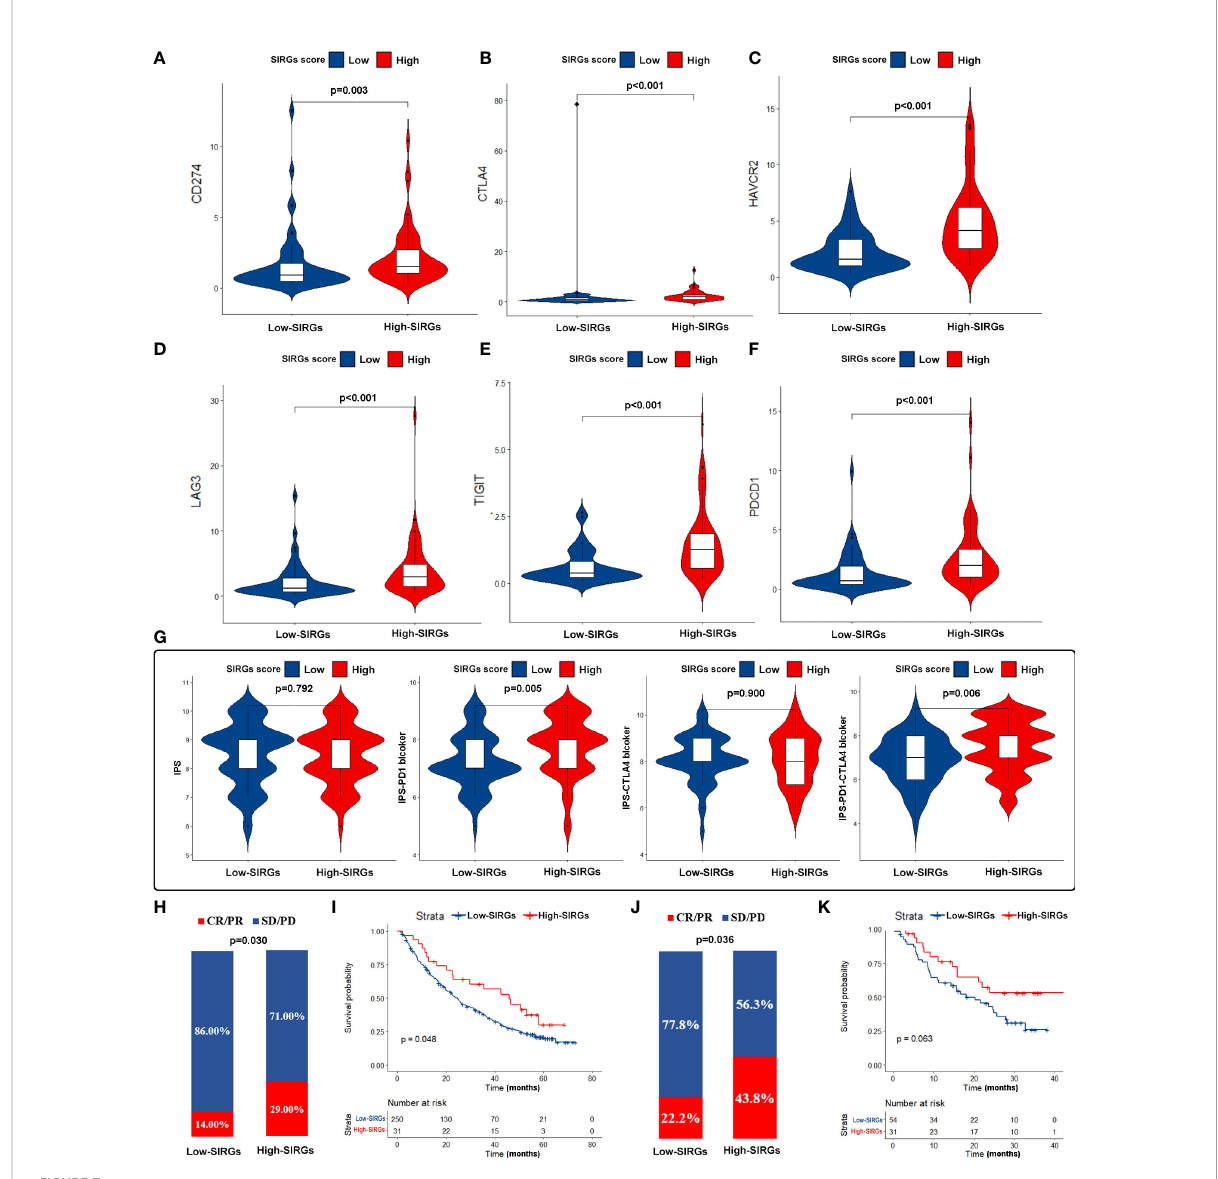
FIGURE 7 The estimation and validation of two SIRGs score groups in immunotherapy response. (A-F) The different expression of six immune checkpoint molecules (CD274, CTLA4, HAVCR2, LAG3, TIGIT, PDCD1) in different SIRGs score groups; (G) The association between IPS and SIRGs score; (H) The different immunotherapy response between two SIRGs score groups in advanced clear cell renal cell carcinoma cohort; (I) The association between SIRGs score and OS in advanced clear cell renal cell carcinoma cohort; (J) The different immunotherapy response between two SIRGs score groups in melanoma cohort; (K) The association between SIRGs score and OS in melanoma a